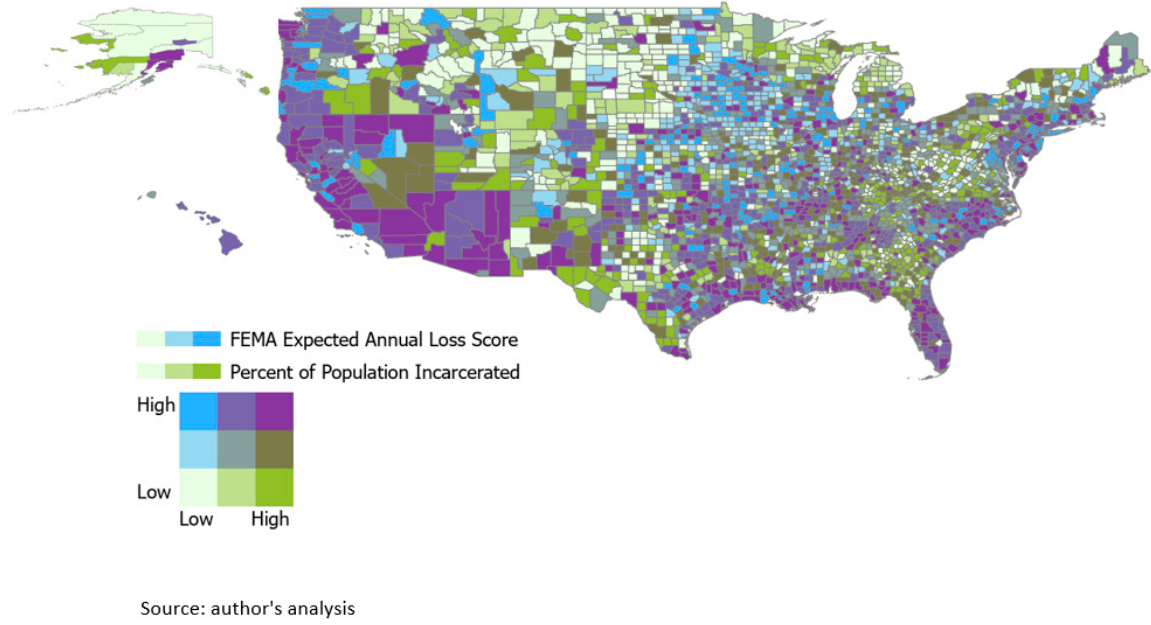
Figure 1. Expected annual loss score tertiles by percentage of population incarcerated tertiles.